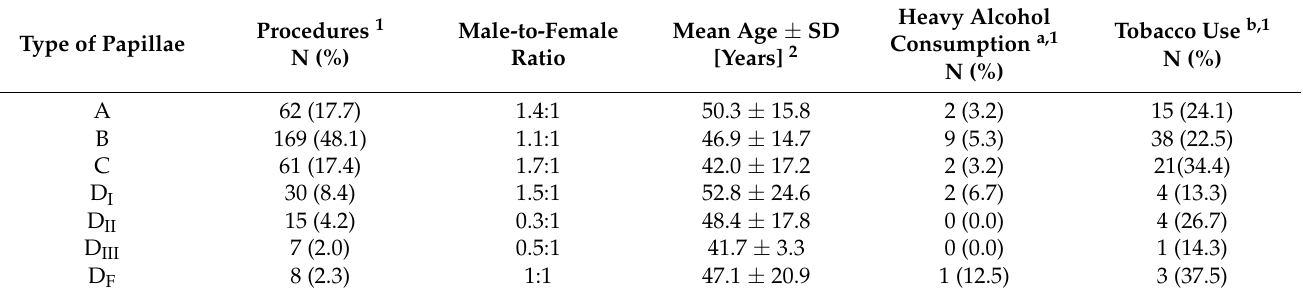
Table 1. Analysis of demographic data.